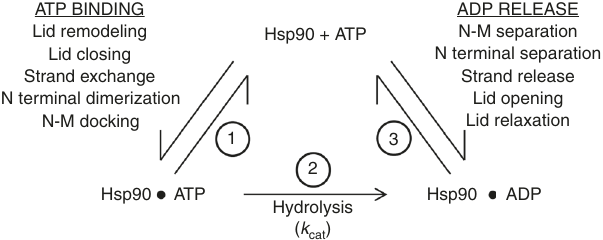
Fig. 10 A simpli fi ed schematic of the Hsp90 ATPase cycle. ATP binding is accompanied by several conformational rearrangements that must occur for Hsp90 to attain its catalytic state (1). Once ATP hydrolysis occurs (2), these conformational changes must be reversed for ADP to be released and another round of ATP binding and hydrolysis to be initiated